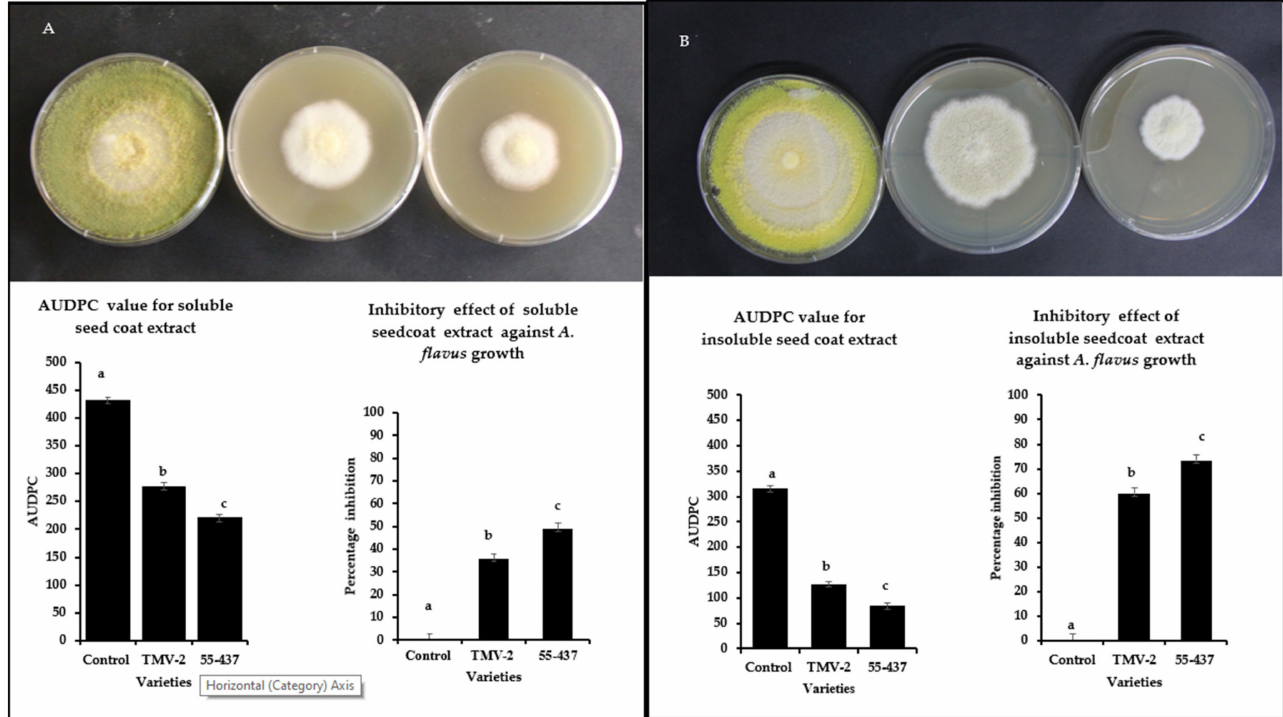
Figure 2. Radial growth bioassay of extracted soluble and insoluble peanut seed coat biochemicals from TMV-2 and 55-437. PDA media plates containing seed coat biochemicals extracts were inoculated with 10 µ L of A. flavus spores (1 × 10 7 CFU mL − 1 ) and incubated at 28 ◦ C. Radial growth was measured and used to calculate the Area Under Disease Progress Curve (AUDPC) and the percentage of inhibition over seven days. One-way ANOVA was used to determine the significant difference between different groups. Means not sharing the same letter are significantly different ( p < 0.05). The error bar represents the standard error ( n = 9). Radial growth of PDA media-containing soluble ( panel ( A )) and insoluble ( panel ( B )) biochemical extracted from peanut seed coat of DMSO control (left), TMV-2 (middle), and 55-437 (right) PDA media